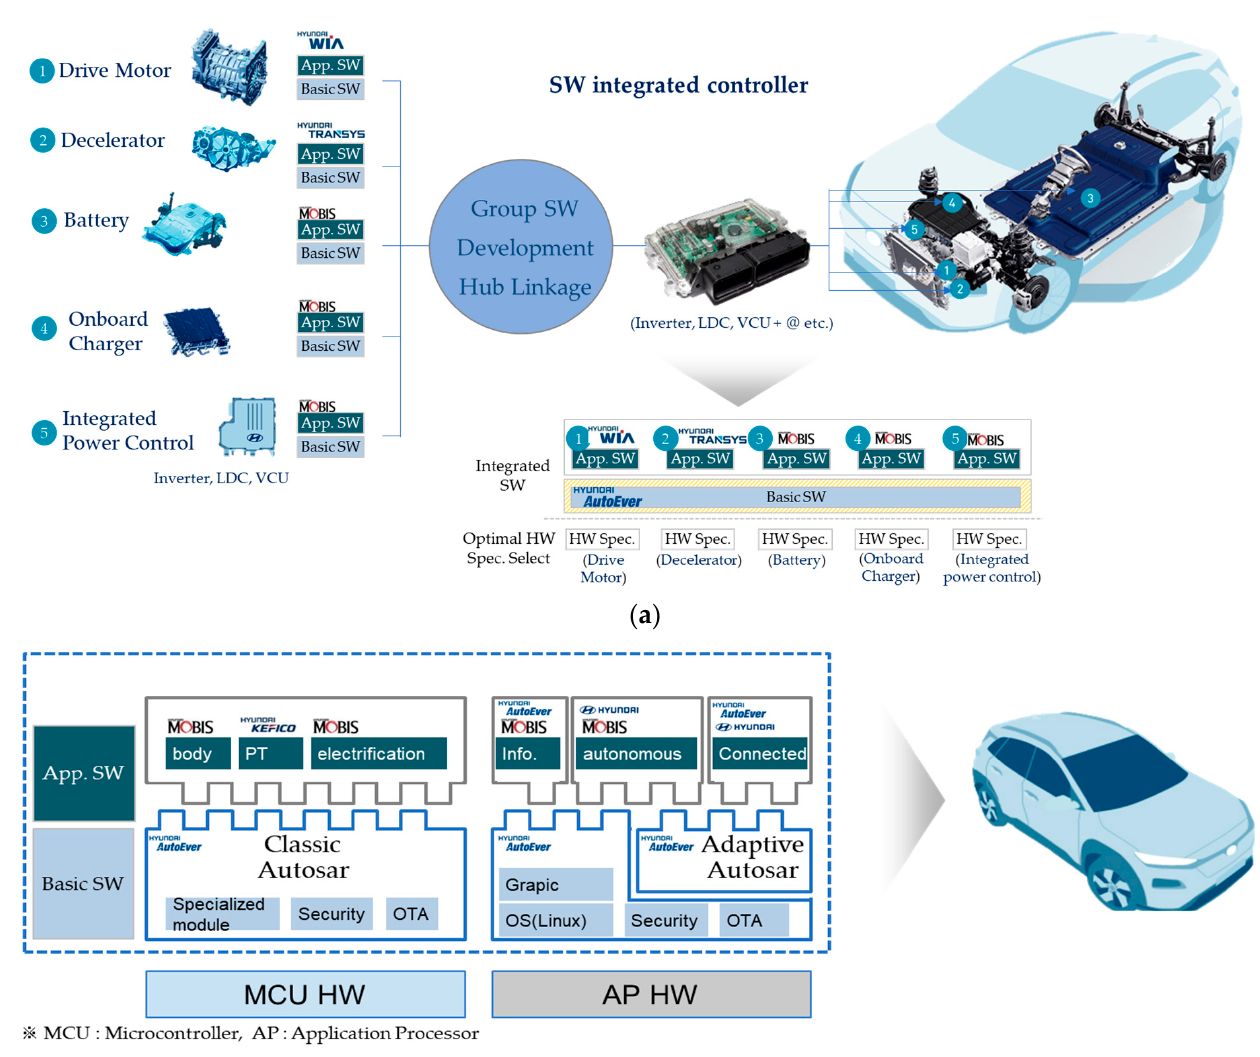
Figure 11. Example of joint development concepts for open innovation (Revised) [63,64]. ( a ) CASE 1. SW integrated controller; ( b ) CASE 2. ADAS +(Advanced Driver Assistance System).